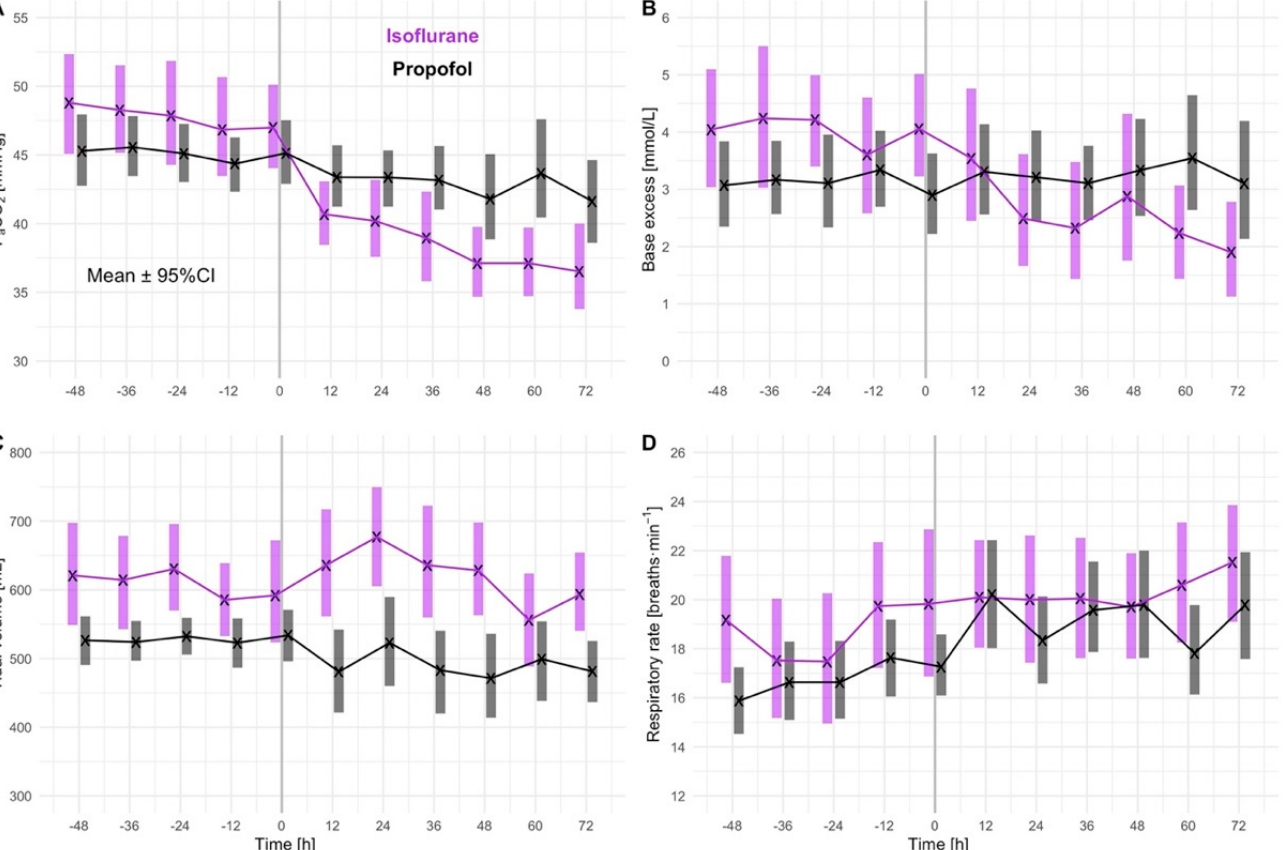
Figure 3. Acid-base balance and ventilation. Sedation was stopped at time point 0. Data are presented in 12-hour intervals as means ± 95% confidence intervals (95%CI). PaCO 2 , arterial carbon dioxide pressure. ( A ) Arterial carbon dioxide partial pressure; ( B ) Base excess; ( C ) Tidal volume; ( D ) Respiratory rate.